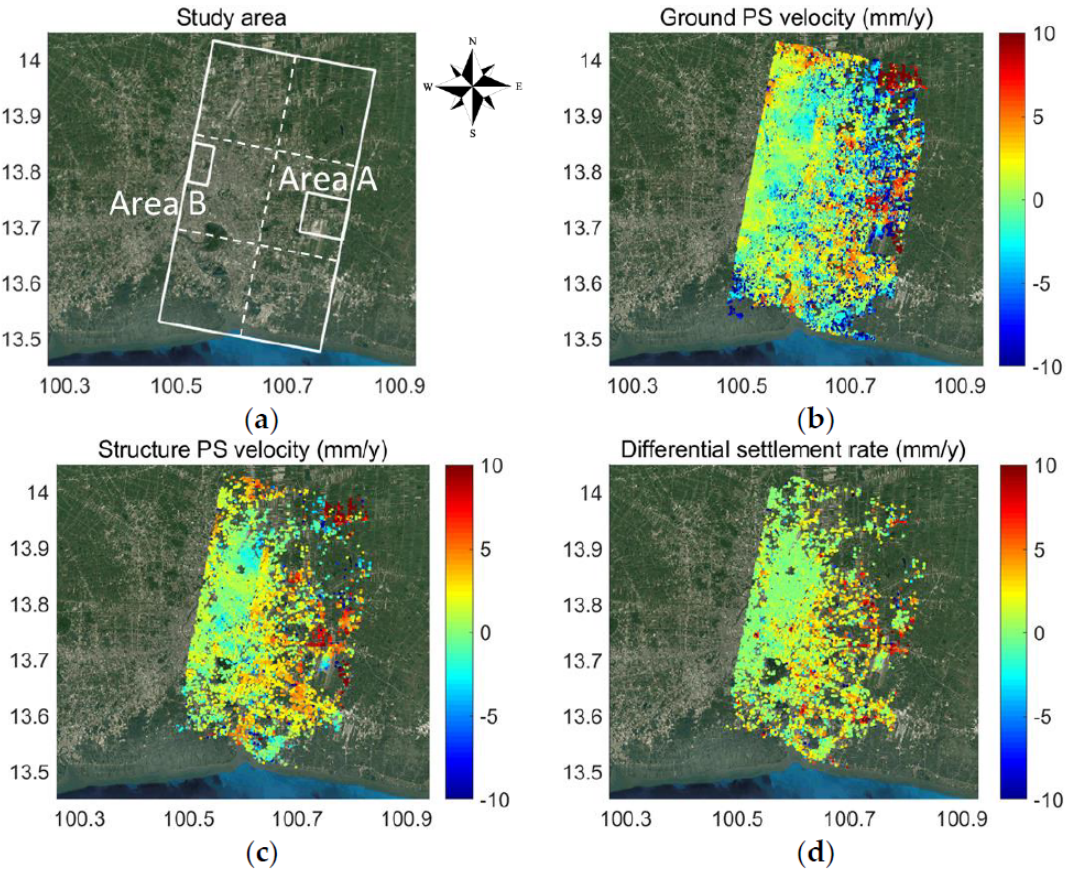
Figure 2. Differential settlement (DS) rate in Bangkok region from 25 November 2009 to 3 December 2010. ( a ) Optical image of Bangkok (Google Maps). The larger white parallelogram denotes the area of the satellite images. The smaller parallelograms denote Areas A and B. ( b ) Ground-derived PS (gPS) rate; ( c ) structure-derived PS (sPS) rate; ( d ) DS rate maps. The background images used in the panels were provided by Google [30] and